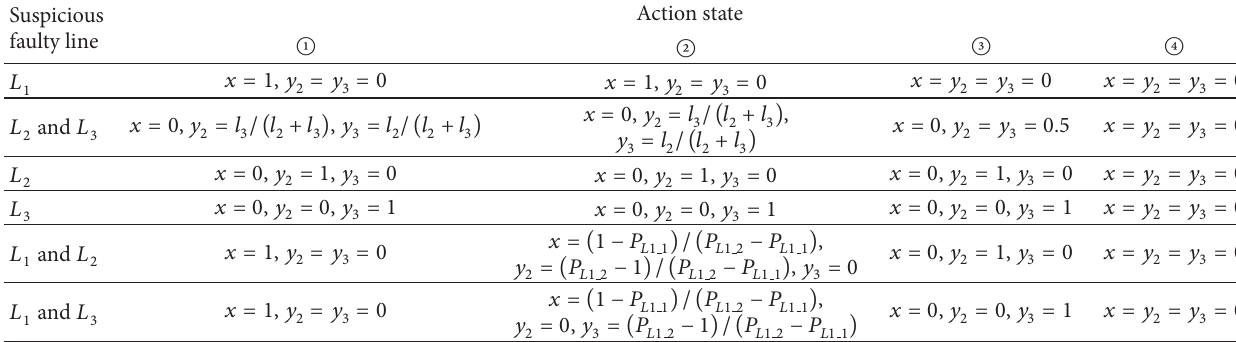
Table 2: Assignment results of BPA values of distance protection of 𝐿 1